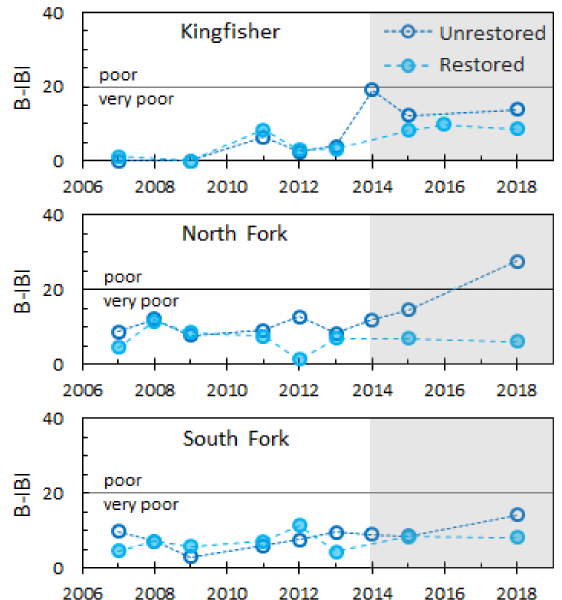
Figure 6. Benthic-Index of Biology Integrity (B-IBI) scores at restored and unrestored reaches for each study site. B-IBI values of 0–19 = very poor, 20–39 = poor, 40–59 = fair, 60–79 = good, and 80–100 = excellent. Construction at restoration sites was completed in November of 2014; post- restoration data are highlighted in grey. B-IBI data were collected by King County on behalf of Seattle Public Utilities and is publicly available at www.pugetsoundstreambenthos.org (accessed on 10 February